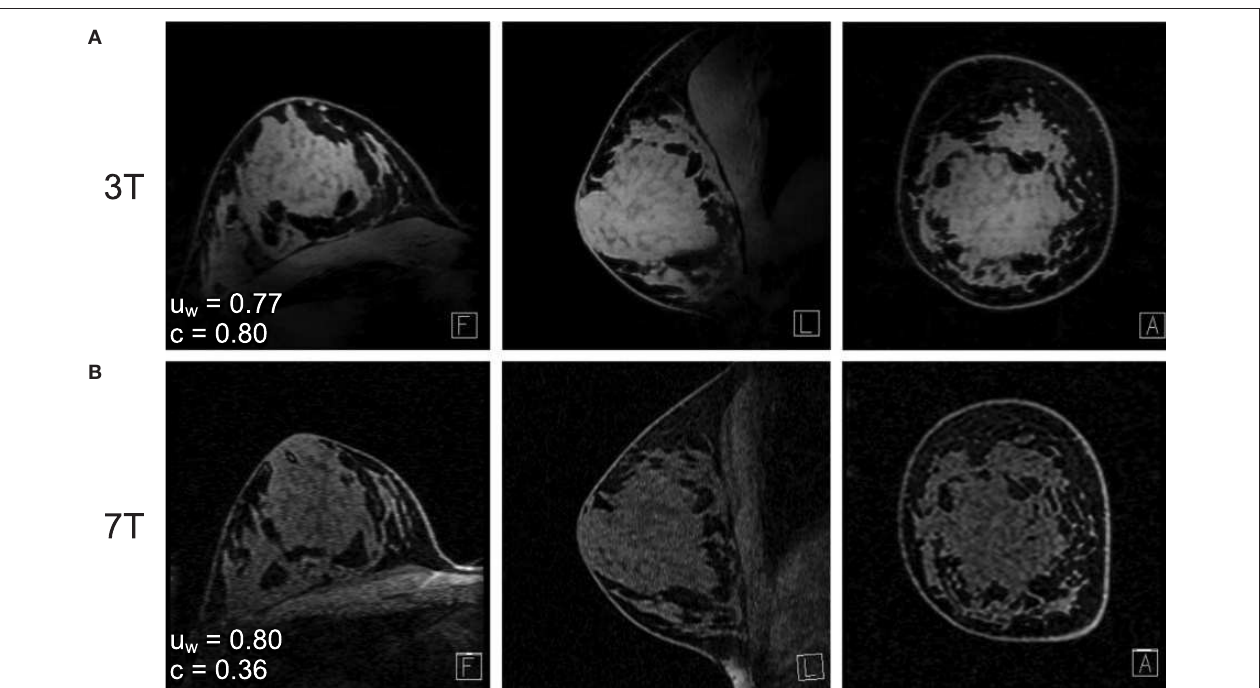
FIGURE 1 | Fat-suppressed T 1 -weighted MRI of the same subject at (A) 7T and (B) 3T. The water signal uniformity (u w ) is similar across 3T and 7T, while the fat-water contrast (c) is markedly improved at 7T. Reprinted with permission from Brown et al. (28); © 2013 Wiley Periodicals,